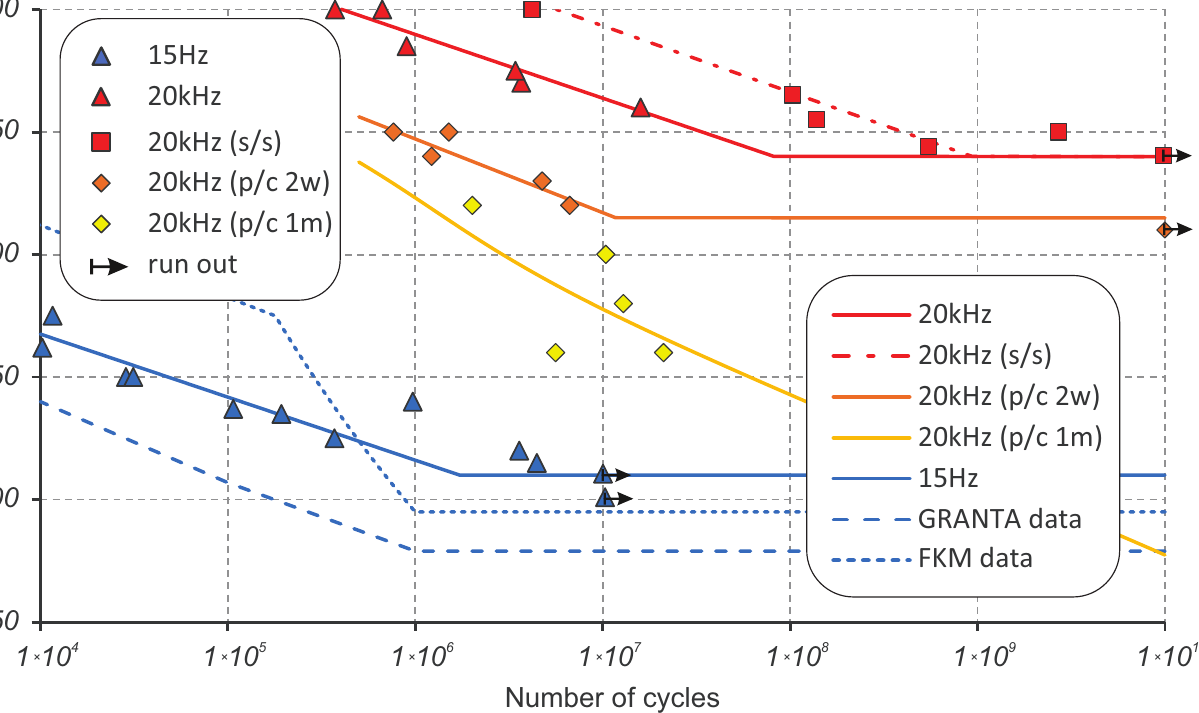
Figure 5. Summary of fatigue testing for S275JR+AR at 15 Hz and 20 kHz including base dry and pre-corroded